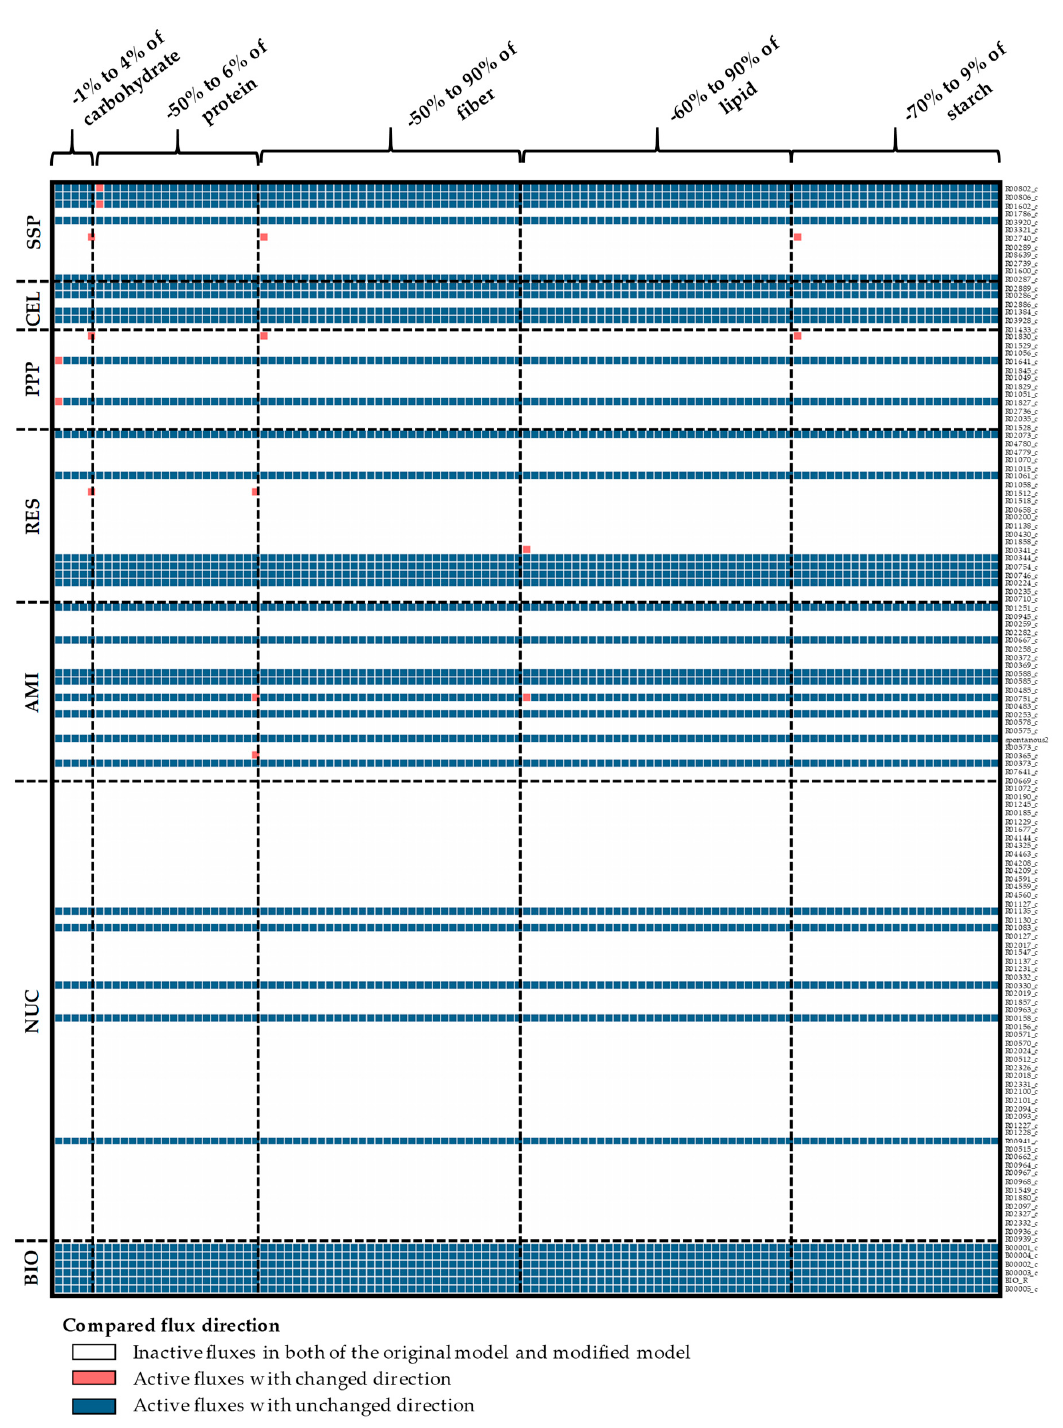
Figure A9. The sensitivity of the cytosolic reaction flux direction to variations in the biomass content. Inactive reactions containing zero fluxes are denoted by white-colored grids. Active reactions, non-zero fluxes, with similar flux direction as the original model are denoted by blue grids; while those with dissimilar flux direction (breakpoint) are denoted by red grids. AMI, amino acid biosynthesis pathway; BIO, biomass reactions; CEL, cell wall biosynthesis pathway; NUC, nucleotide biosynthesis pathway; PPP, pentose phosphate pathway; RES, respiration pathway; SSP, starch and sucrose biosynthesis pathway.